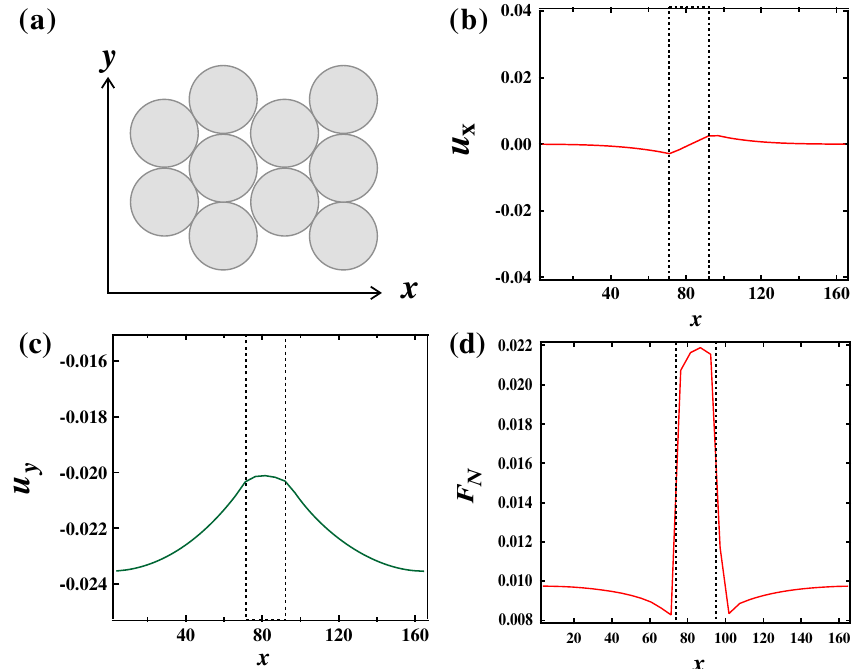
Figure 5. ( a ) Schematic of the arrangement of the triangular lattice. ( b ) Displacement in the x axis direction u x and ( c ) displacement in the y axis direction u y at n y = 12 . ( d ) The normal force F N on the bottom